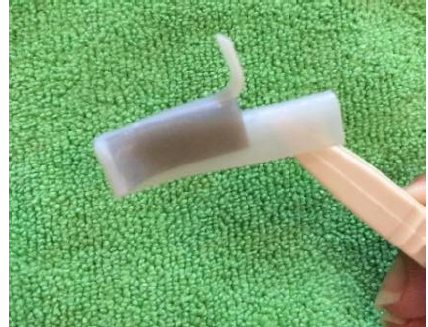
Figure 10. Sequence of crossfolding for method 1.